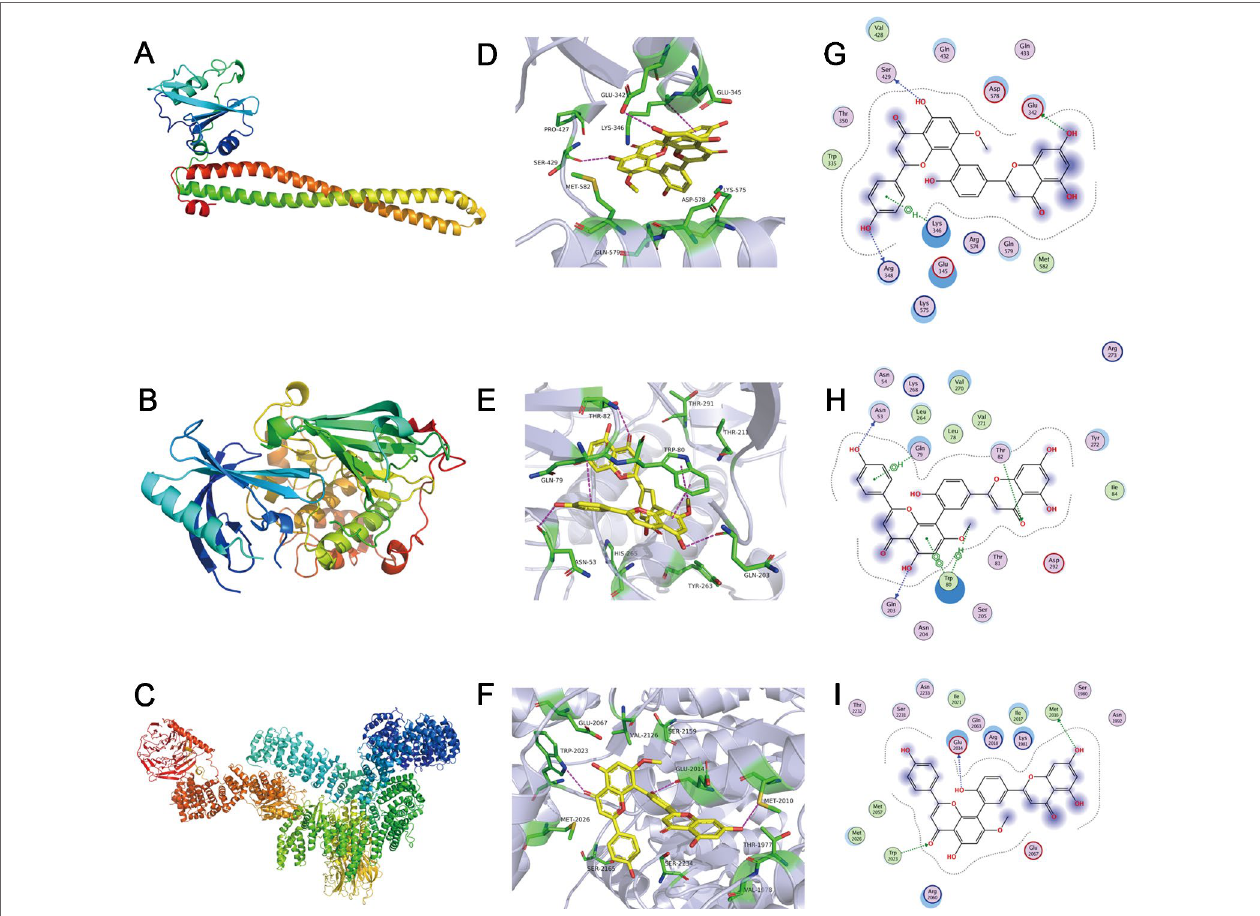
FIgURe 5 | Sotetsuflavone could interact with proteins including PI3K, Akt, and mTOR. (A) 3D structures of human proteins PI3K (PDB-ID:5XGI). (B) The 3D structures of human proteins AKT(PDB-ID:4EGN2). (C) The 3D structures of human proteins mTOR (PDB-ID:6BCX3). (D) The 3D binding mode of sotetsuflavone with PI3K(PDB-ID:5XGI). (e) The 3D binding mode of sotetsuflavone with AKT(PDB-ID:4EGN2). (F) The 3D binding mode of sotetsuflavone with mTOR (PDB- ID:6BCX3). (g) The 2D binding mode of sotetsuflavone with PI3K(PDB-ID:5XGI). (h) The 2D binding mode of sotetsuflavone with AKT(PDB-ID:4EGN2). (I) The 2D binding mode of sotetsuflavone with mTOR (PDB-ID:6BCX3). In the image, sotetsuflavone is colored in yellow, and the surrounding residues in the binding pockets are colored in green. The backbone of the receptor is depicted as light blue